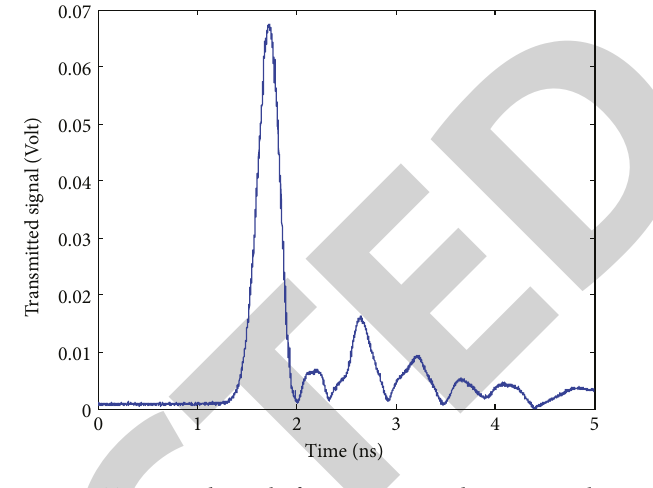
Figure 1: Transmitted signal of a 300-picosecond Gaussian pulse shape.